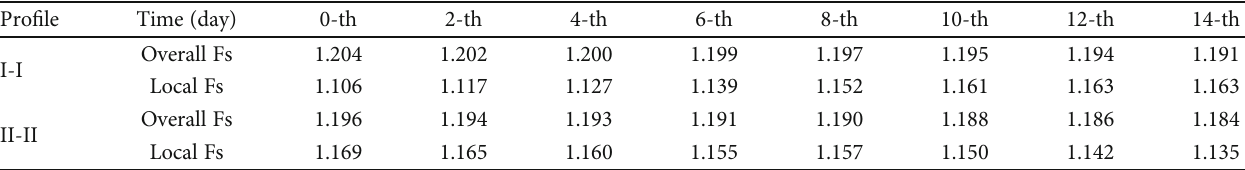
Figure 9: The dynamic seepage fi eld for the two pro fi les extracted from the glacio fl uvial deposit slope in the fast impoundment condition: (a) pro fi le I-I; (b) pro fi le II-II. Table 3: The safety factor of the pro fi les during the fast impoundment